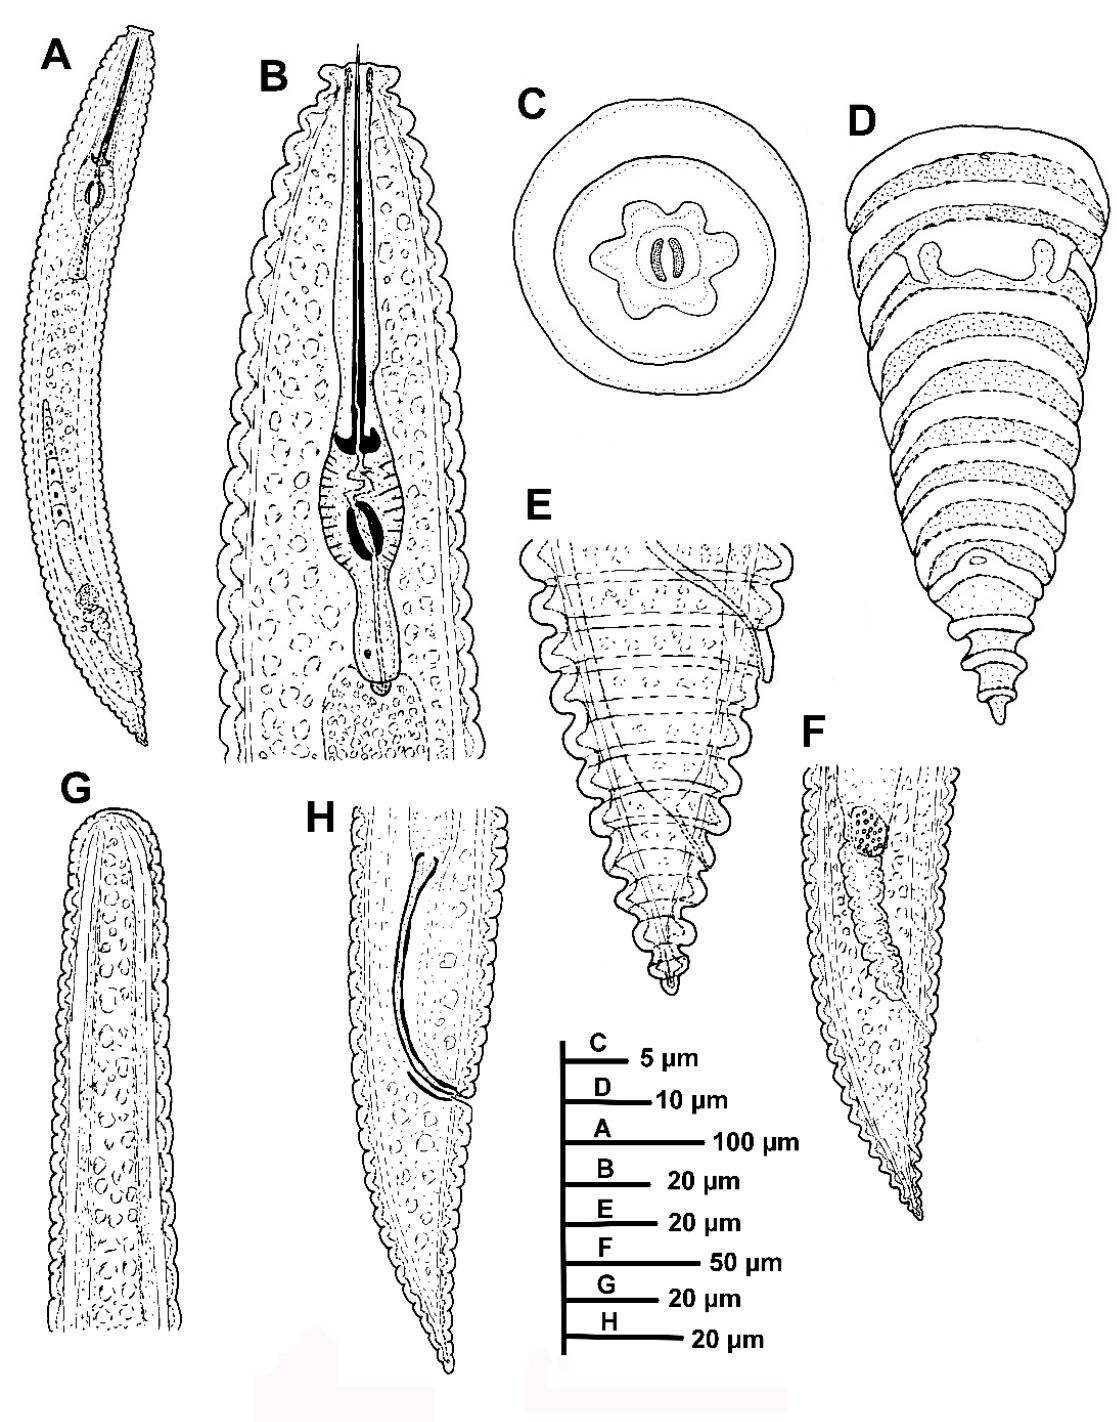
Figure 3. Line drawings of Criconema pseudoannuliferum sp. nov. ( A ), whole female, ( B ) female anterior region; ( C ), detail of en face view; ( D ), female posterior region in frontal view showing vulva and anus, ( E,F ) female posterior region; ( G ), male anterior region showing absence of stylet; ( H ), male posterior region.